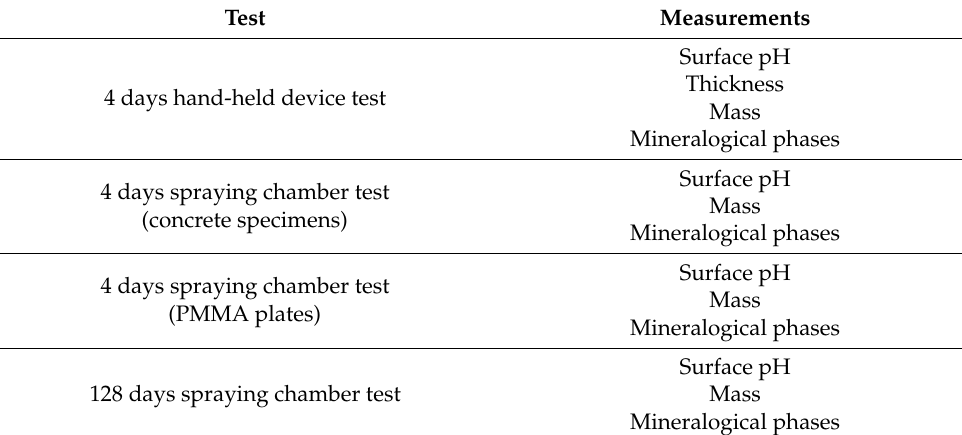
Table 2. The acid spraying tests and the respective